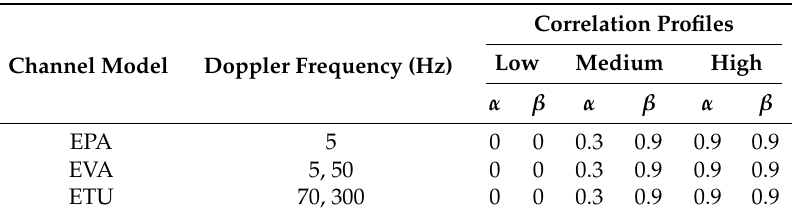
Table 2. Channel model parameters